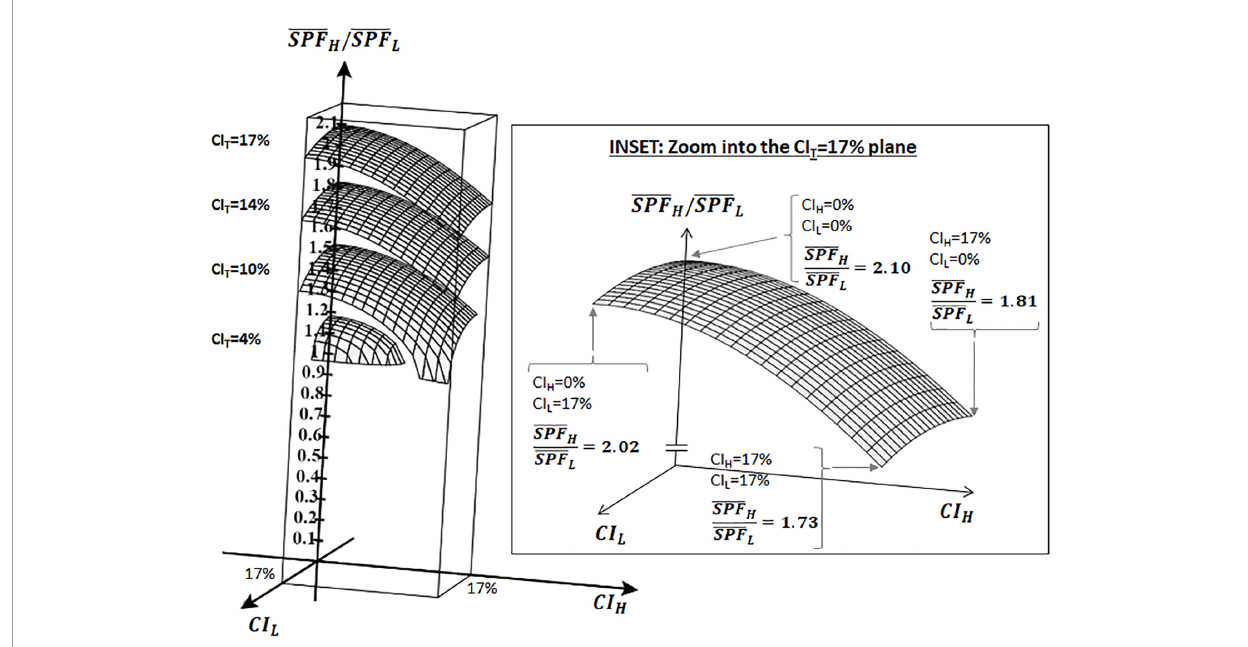
FIGURE1 Ratio of SPF H / SPF L as a function of CI H , CI L , and CI T as per Equation 2: 3D graph showing the ratio ( SPF H / SPF L ) between two independent ISO-valid SPF results (L and H) with n = 10 each. Ratio is shown on the vertical axis, CI L and CI H are shown on the x and y axes. Data shown for the cases of CI T = 4, 10, 14, and 17%. Inset zooms into CI T = 17%.